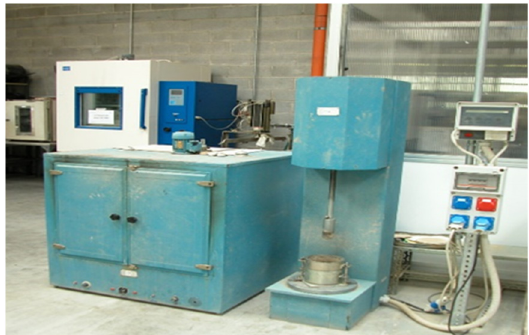
Figure 5. Determination of OMC and MDD with a proctor test.